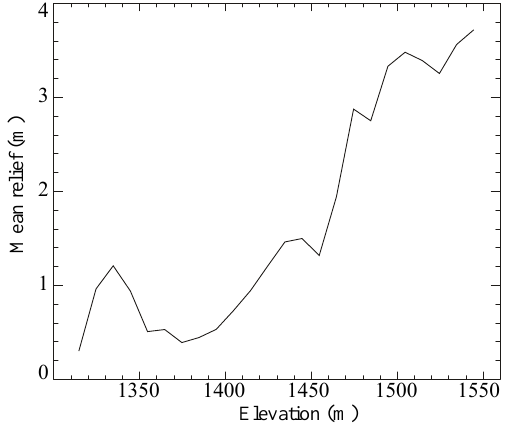
Figure 6. Plot of mean hillslope relief as a function of elevation, il- lustrating the marked increase in relief above elevations of approx- imately 1430ma.s.l. in the study area. Each data point represents the mean hillslope relief in 10m wide elevation bins.